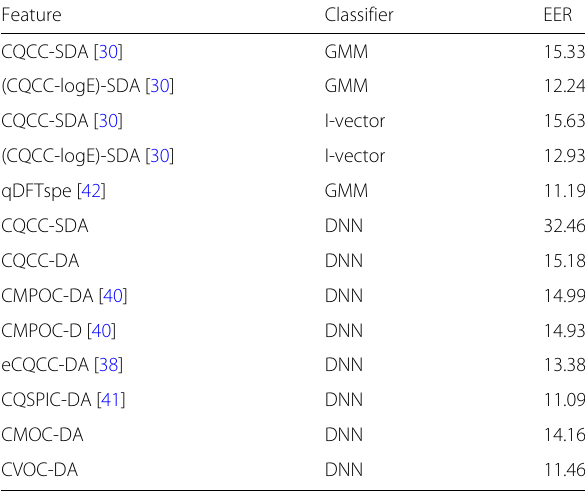
Table 10 Experimental results (t-DCF and EER(%)) on ASVspoof 2019 physical access development set using dynamic features of